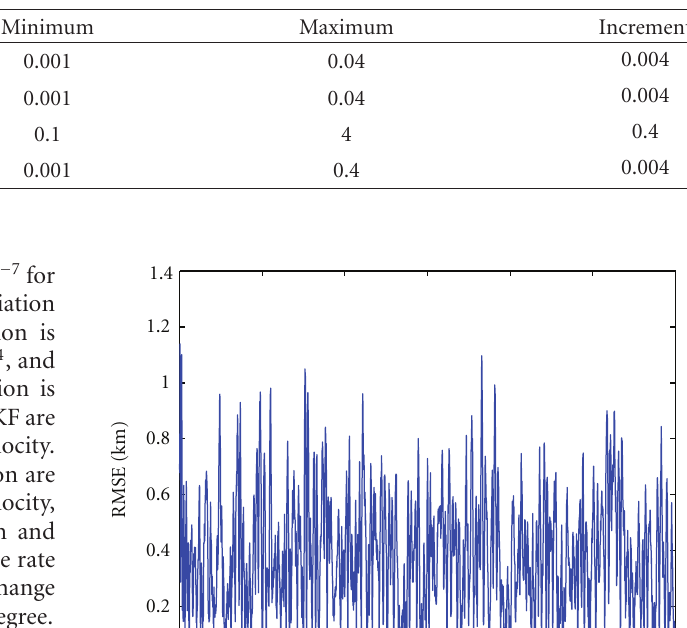
Table 3: Measurement noise’s set configuration.